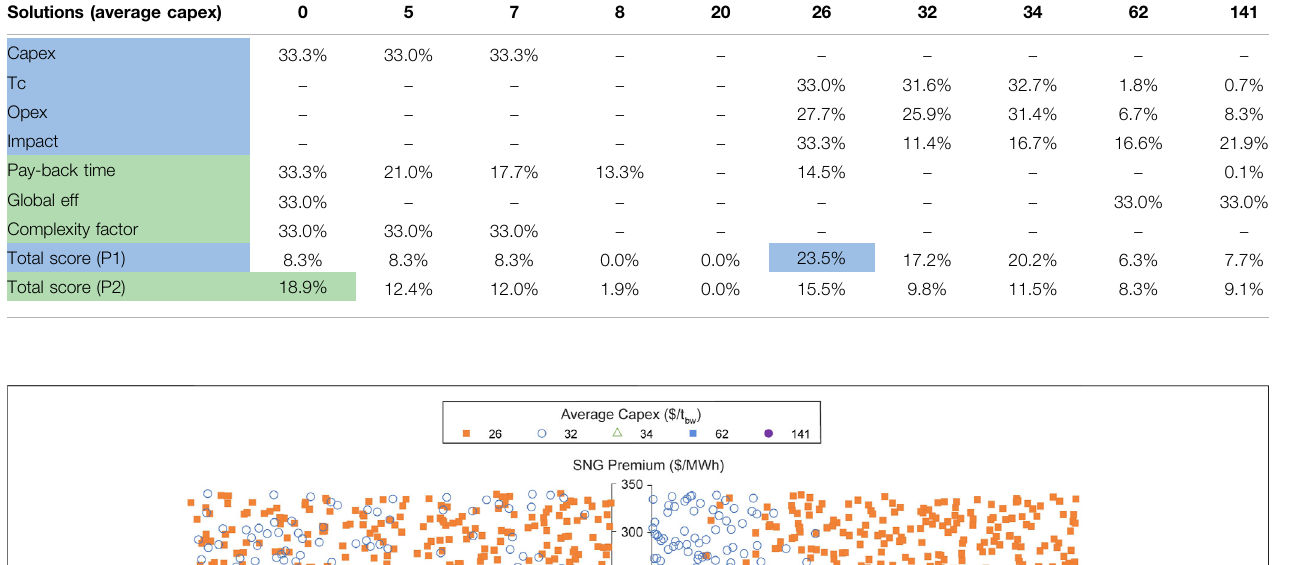
TABLE 4 | Solutions probabilistic ranking (normalized) ranged by increasing capex and pertaining to two ranking systems: P1, containing only MILP objectives; P2 adding thermodynamic and con fi guration indicators. Highlighted scores achieve the highest global performance assuming uniform weights. Solutions (average capex)